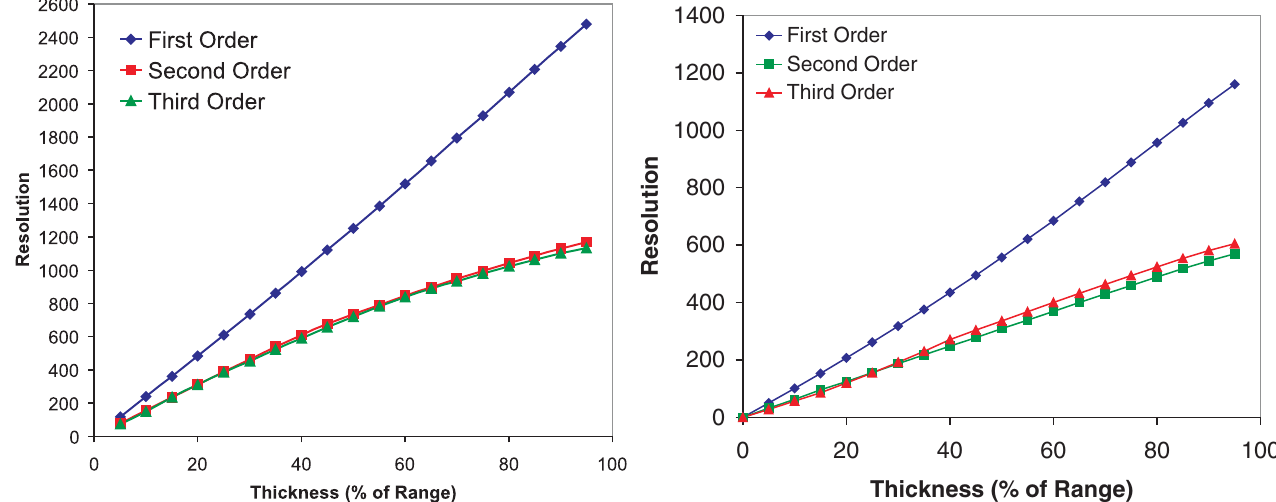
FIG. 12. (Color) Mass (left) and charge (right) resolving powers for a 200 MeV = u 132 Sn beam and Al wedge as a function of wedge thickness evaluated at different map